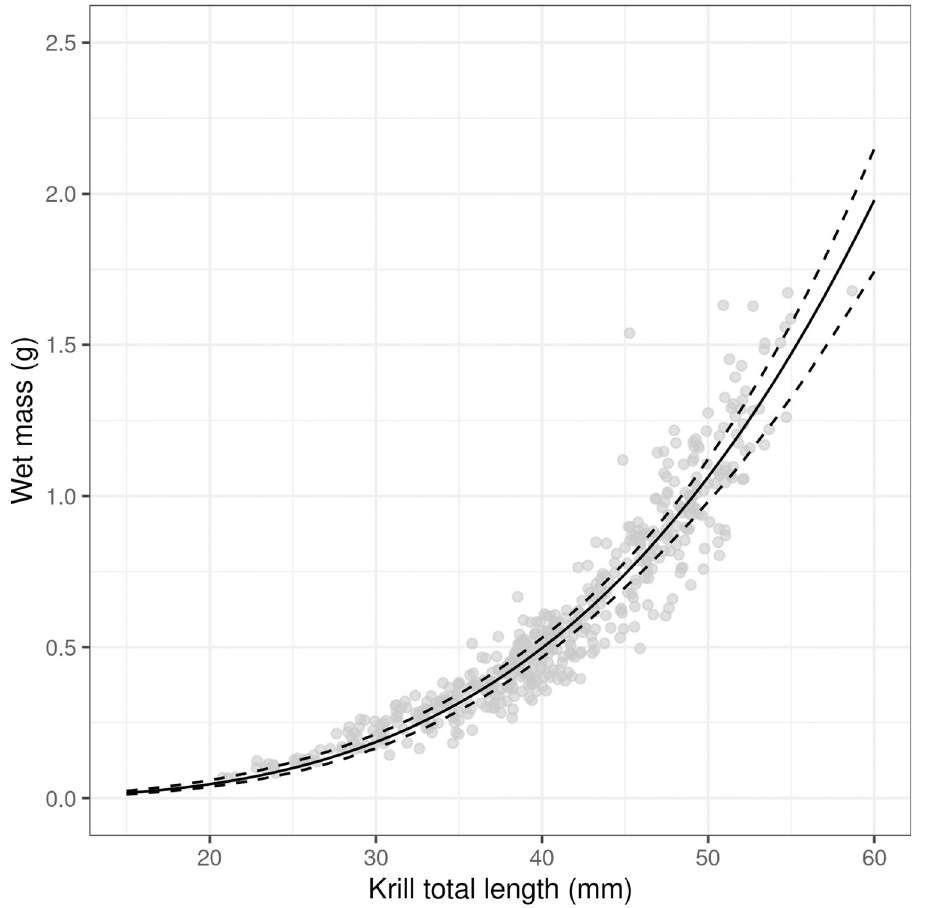
Fig 5. Krill total length to wet mass relationship. Observations are grey semi-transparent dots, the fitted model is a solid black line and the 95% confidence intervals, determined by non-parametric bootstrap, are dashed lines.